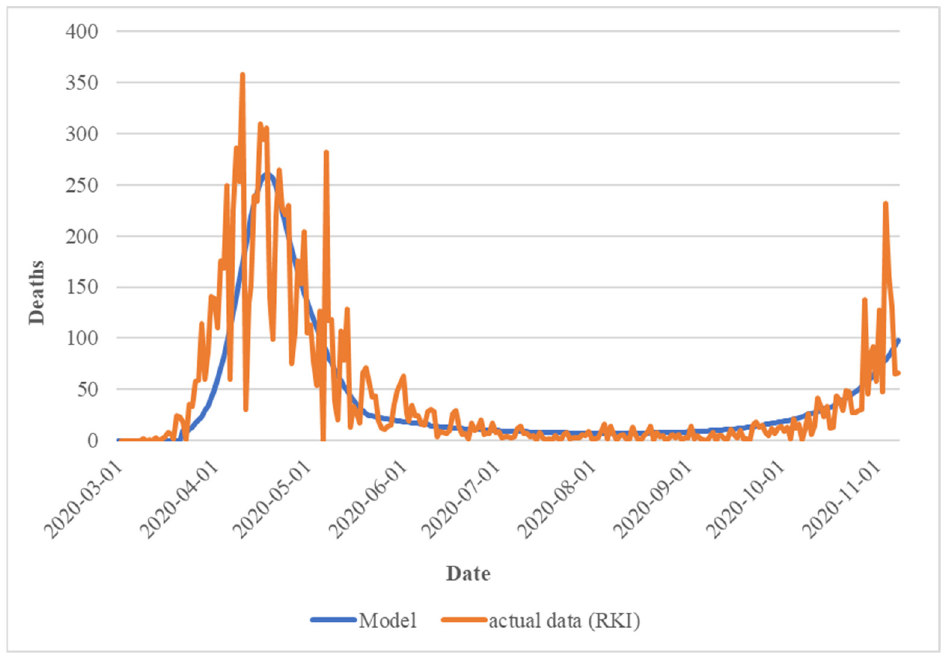
Figure 1. Comparison of deaths per year: calibrated Nov. model vs. actual data.